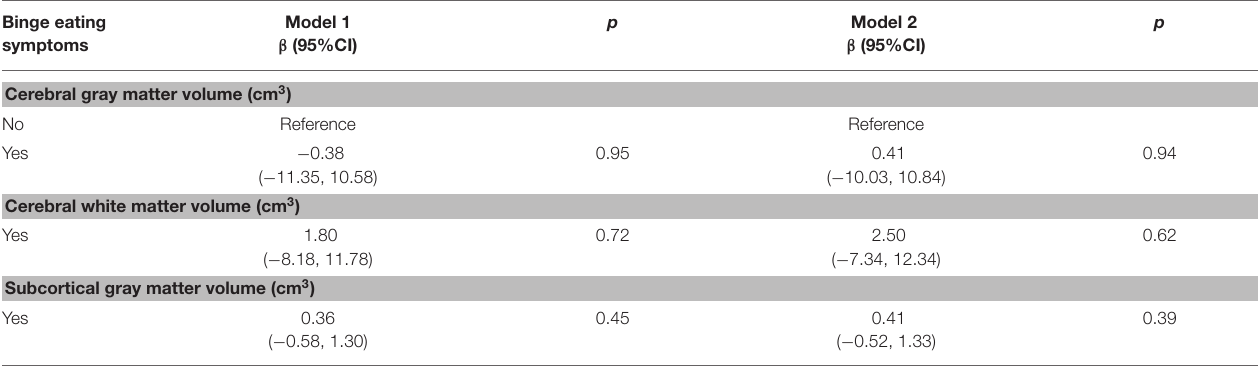
TABLE 3 | Associations of binge eating symptoms at age 13 years with global brain volumes at age 13 years. Binge eating